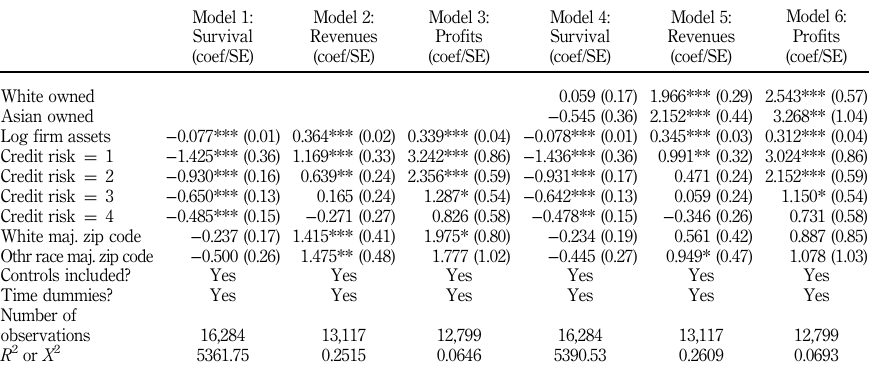
Table AI. Assets, credit risk and race location based pooled regressions